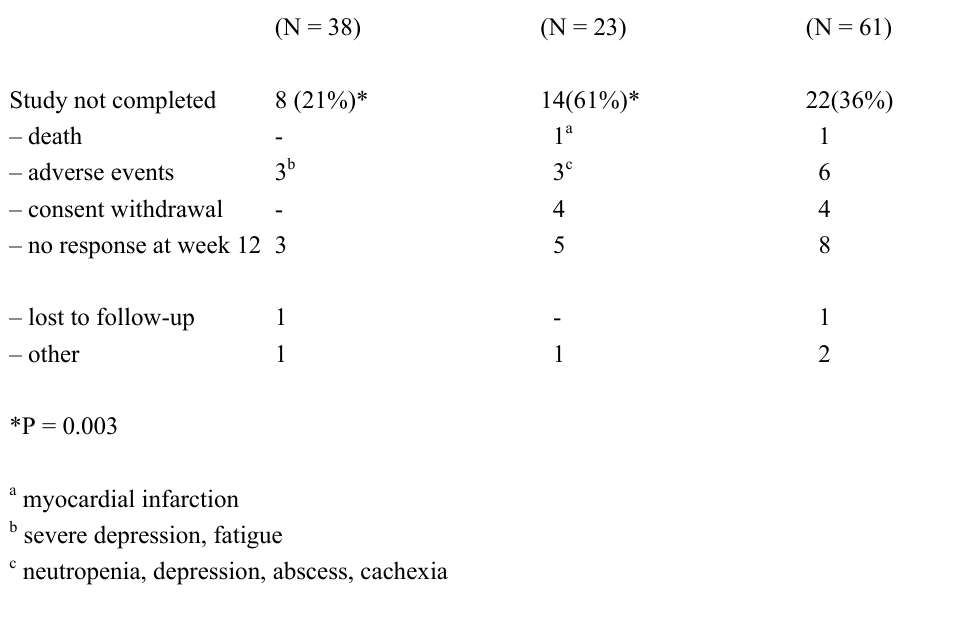
Frequency and percentage of adverse events and reasons for not completing the study (genotypes 1 and 4). HCV